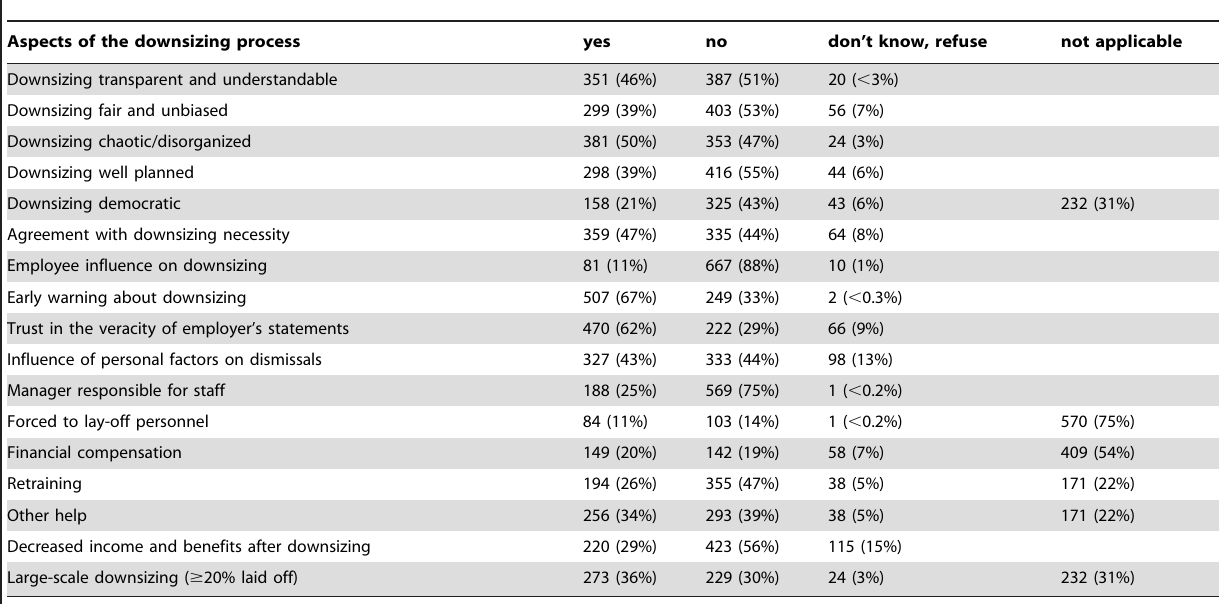
Table 2. Responses for experienced downsizing and related conditions, data are number